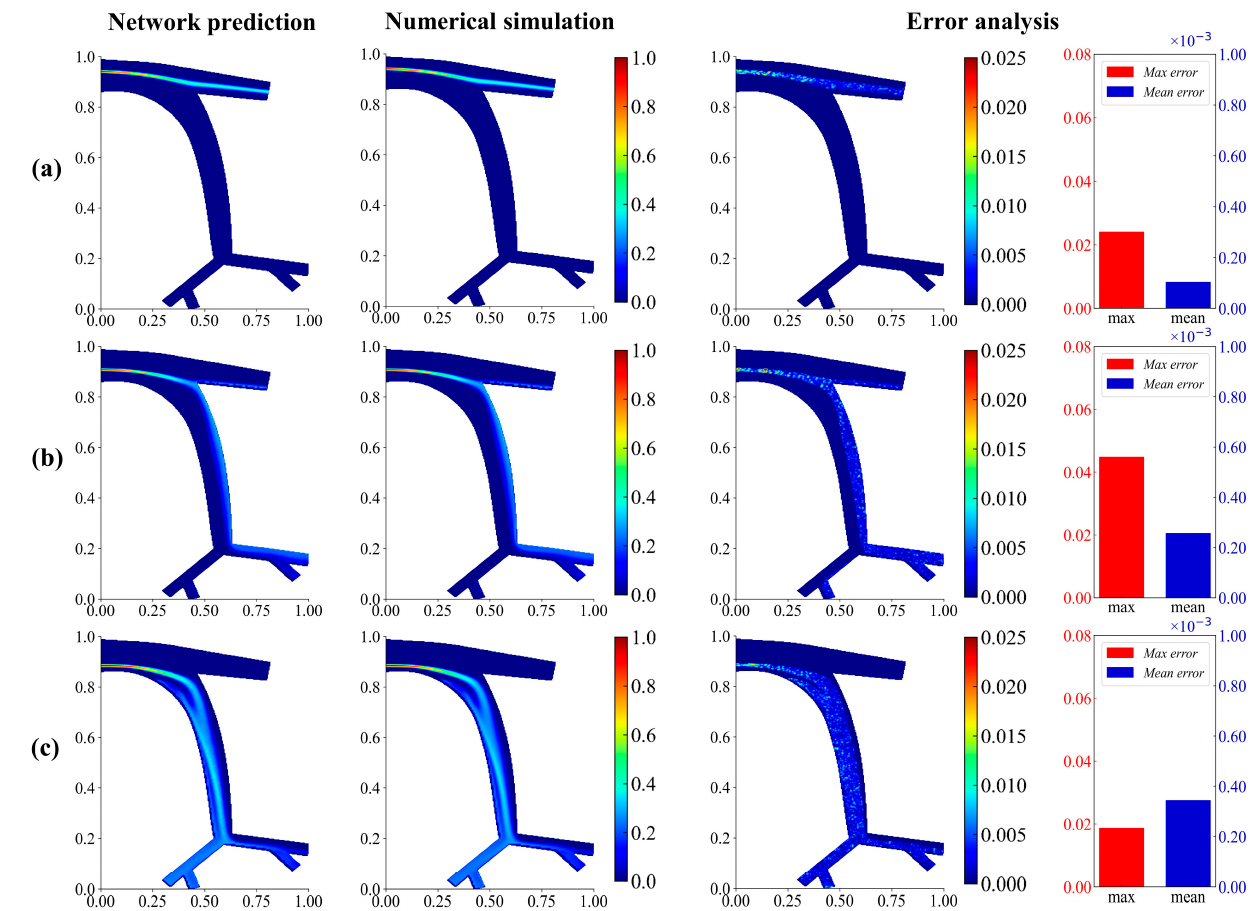
Figure 7. Drug concentration field and error distribution for the human hepatic artery at time t = 2.1 and three injection locations ( a ) 0.2 R, ( b ) − 0.36 R and ( c ) − 0.8 R from the central axis of the blood vessel.